Question: What direction does the quantity move in — increasing or decreasing?
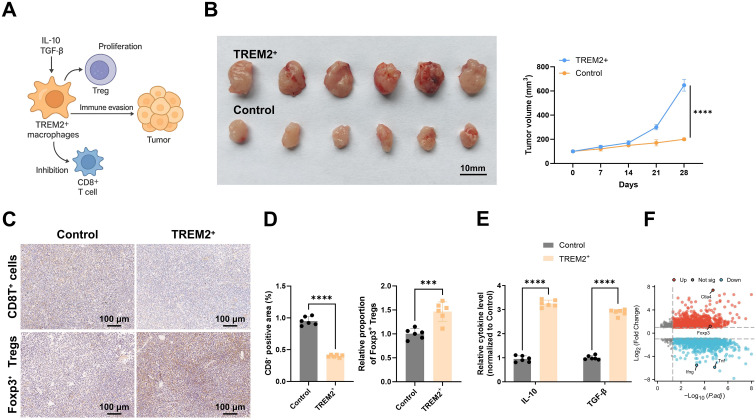
Answer: increasing